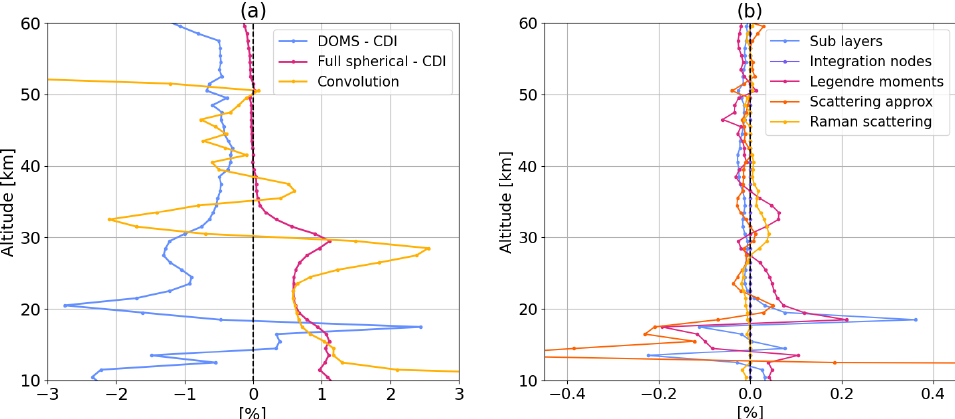
Figure 10. (a) Relative difference in the ozone profiles for different RT solvers and approximations for atmospheric sphericity. (b) Relative differences when changing scattering approximation and computation